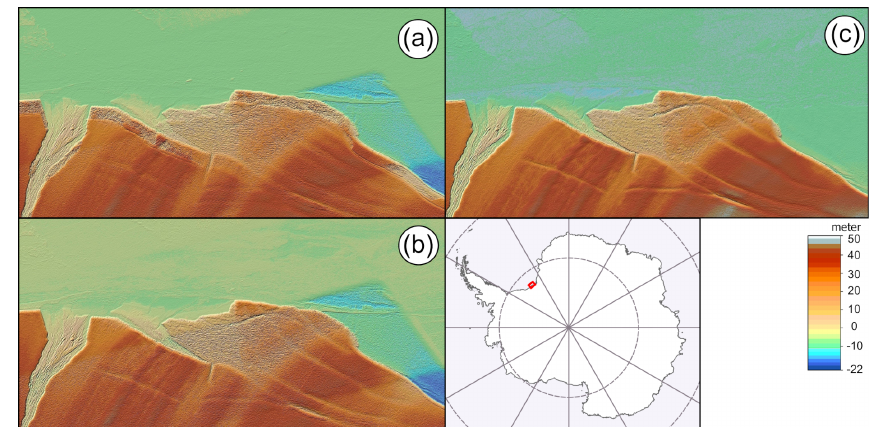
Figure 5. DEM mosaicking iterations at Filchner ice shelf. (a) First mosaicking with all acquisitions from mid-2013 and mid-2014, (b) second mosaicking with 2014 acquisitions only, and (c) third mosaicking with 2014 ascending acquisitions only.